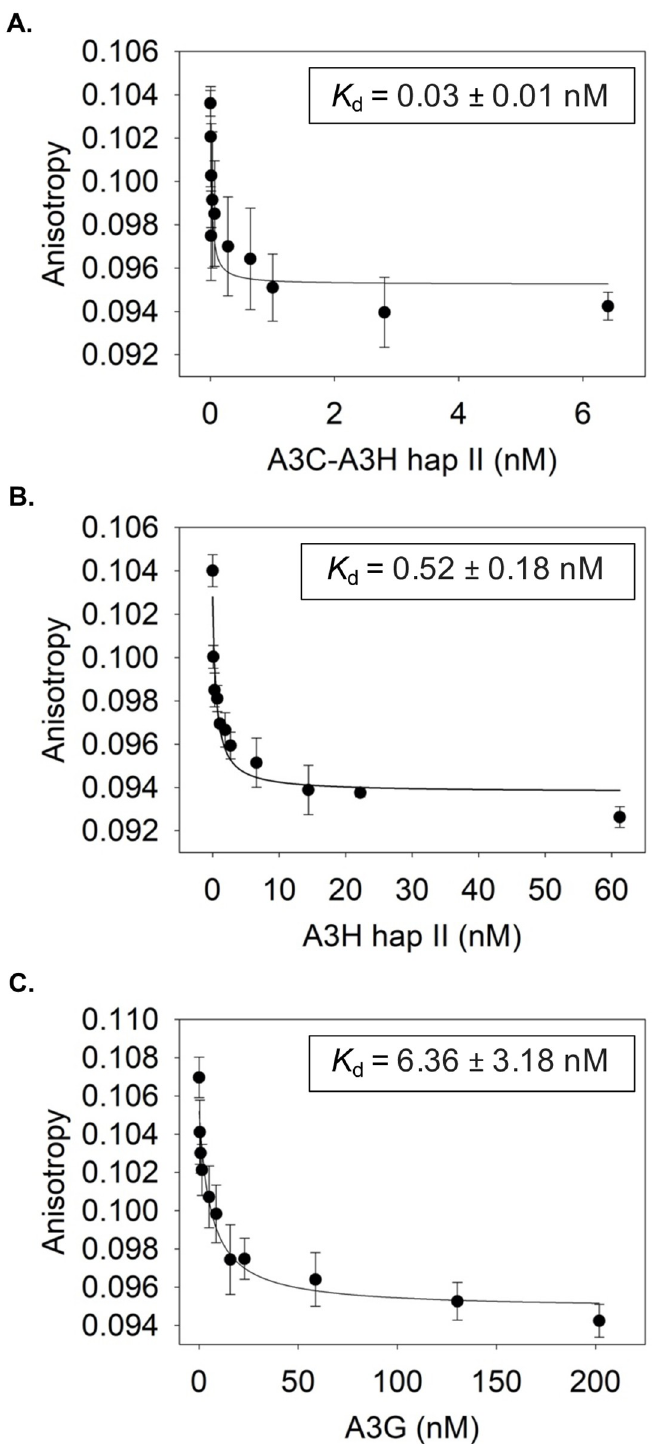
Fig 4. A3C-A3H has increased binding affinity for the HIV-1 5’UTR. The apparent K d of A3 enzymes from the fluorescein labeled 497 nt RNA was analyzed by steady-state rotational anisotropy for (A) A3C-A3H hap II (0.03 ± 0.01 nM); (B) A3H hap II (0.52 ± 0.18 nM) and (C) A3G (6.36 ± 3.18 nM). The x-axis on each graph is different due to the different amount of protein added in order to fully saturate the RNA. Error bars represent the standard deviation from three independent